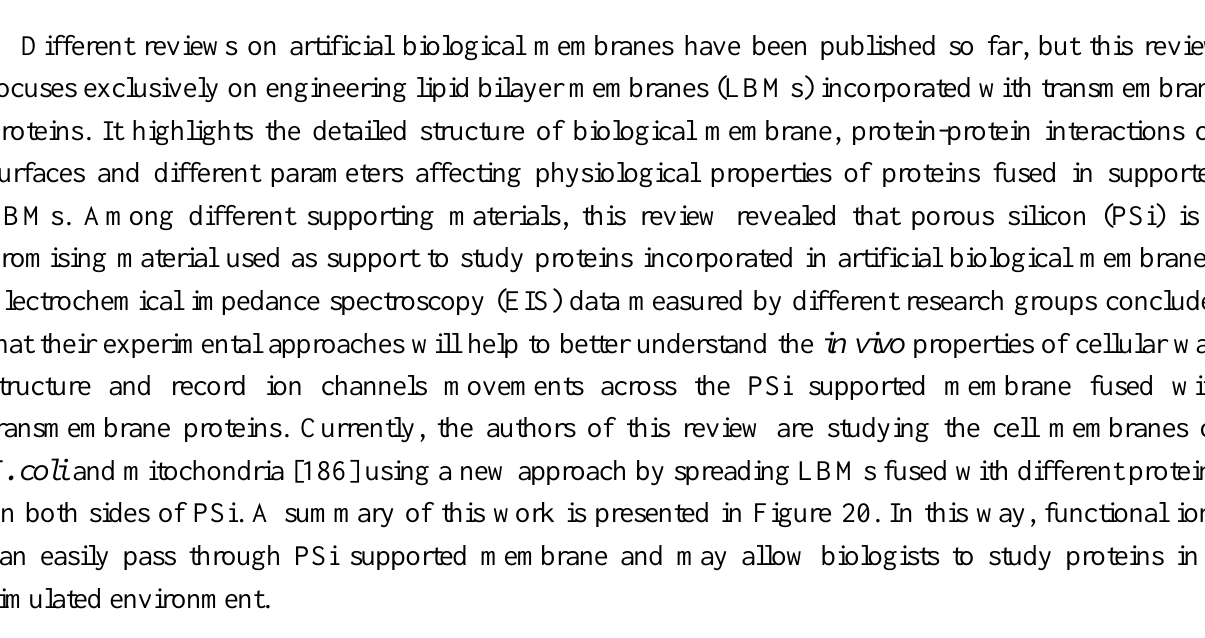
Figure 20. Prototype description of real time in vivo monitoring of different proteins fused in lipid bilayer membrane (LBM) on each side of porous silicon